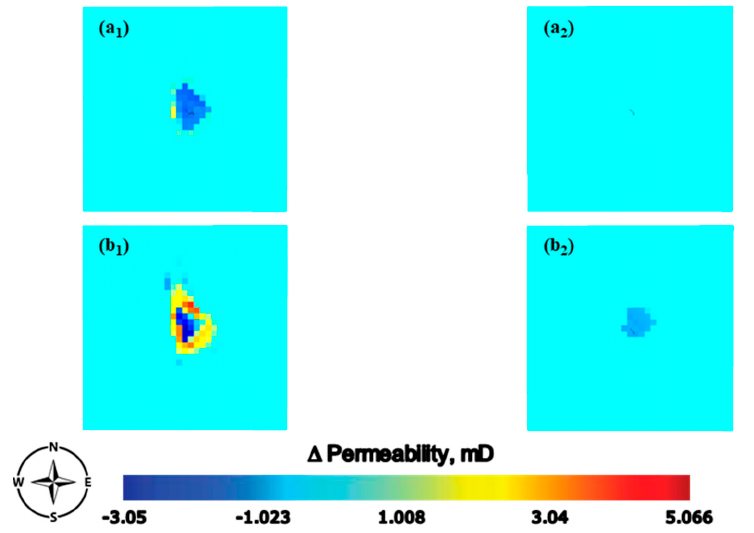
Figure A8. Plan view diagrams illustrating the simulated ∆ permeability evolution for the base case from the arkosic layer top view ( a 1 , b 1 ) and homogenous case from the Upper Mt. Simon top view ( a 2 , b 2 ) at ( a ) 1000 years, and ( b ) 10,000 years. Each figure’s size is 35 km × 35 km (x, y).